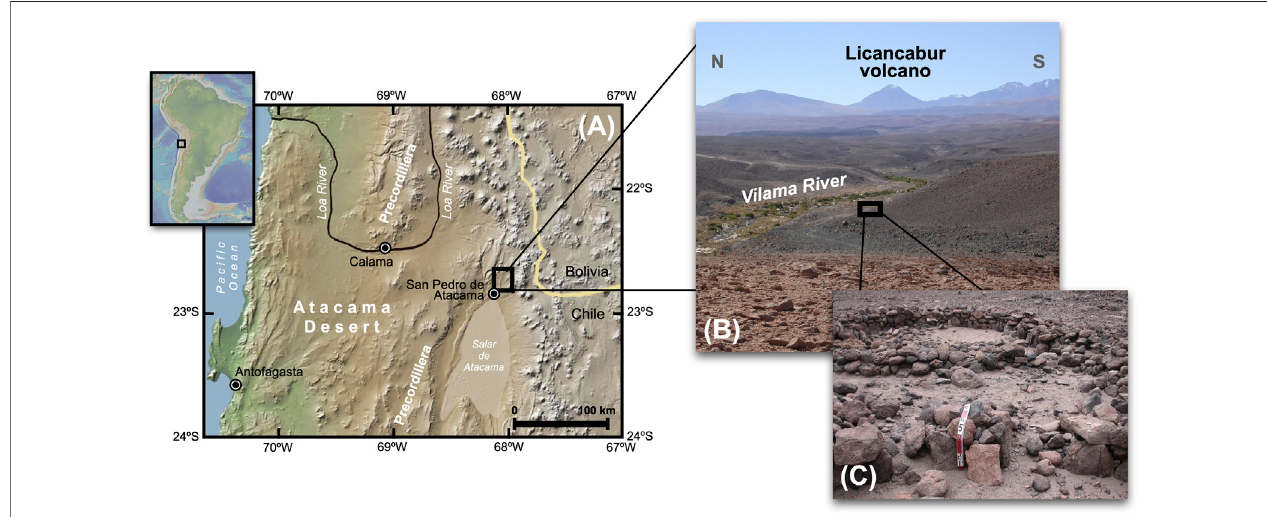
FIGURE1| Studyarea. (A) MapoftheCentralAndesbetween21 ° 20 ′ to24 ° Sshowingthelocationofthestudyarea.Mapcreated usingthe “ GeoMapApp ” (www. geomapapp.org, Ryan et al., 2009). Photographs showing a panoramic view of the Ghatchi archaeological sites in the Vilama River (B) and local Formative Period domestic structures (C)